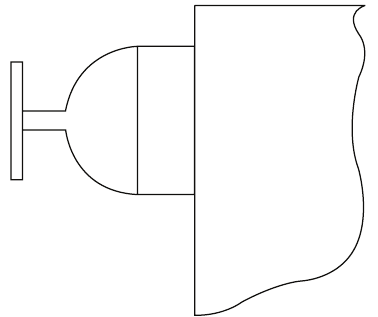
Figure 3: Solar water distillation with multiple e ff ect wicking system.